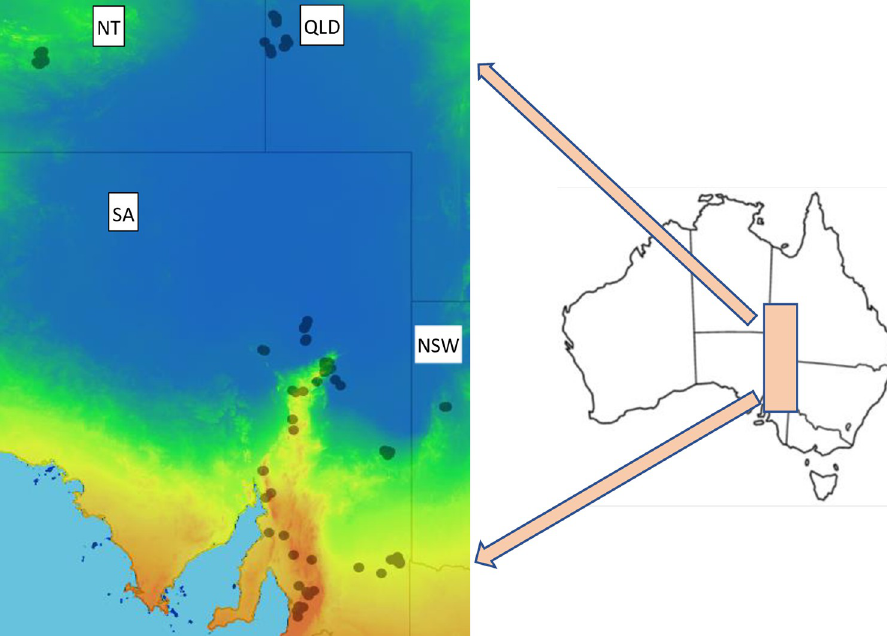
Fig 1. Location of the repeatedly surveyed plots. Location of the repeatedly surveyed plots within the Northern Territory (NT), Queensland (QLD), South Australia (SA), and New South Wales (NSW). Three plots from Western Australia are not shown. The background layer represents the annual mean aridity index (precipitation/evaporation) from the more arid areas in blue to the more mesic areas in orange. The Australian outline map indicates the location within the continent. Maps downloaded from the Atlas of Living Australia. https://spatial.ala.org.au. Accessed 1 November 2022. Creative Commons license CC BY 3.0